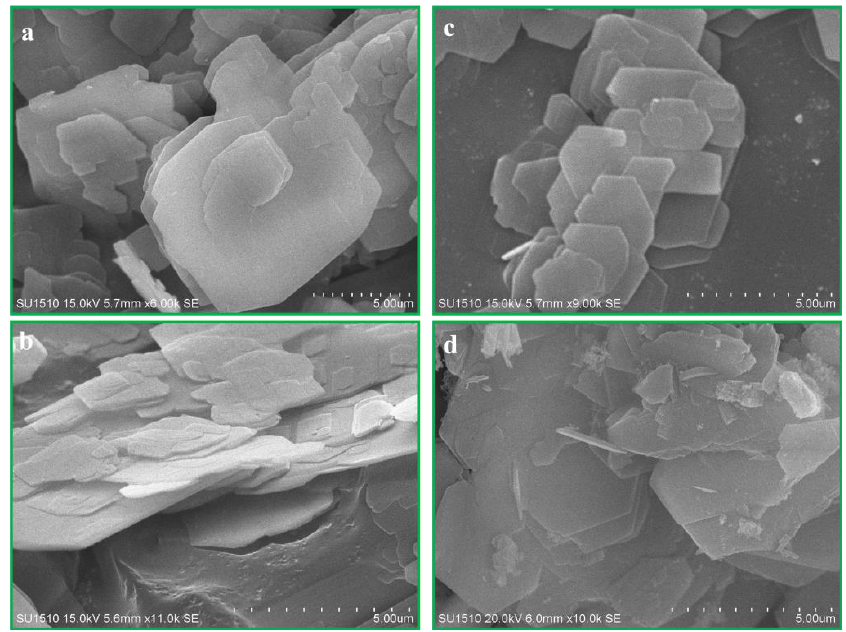
Figure 3. SEM images of ( a ) RUB-36, ( b ) RUB-37, ( c ) Sn-JHP-1 and ( d ) Sn-JHP-2.